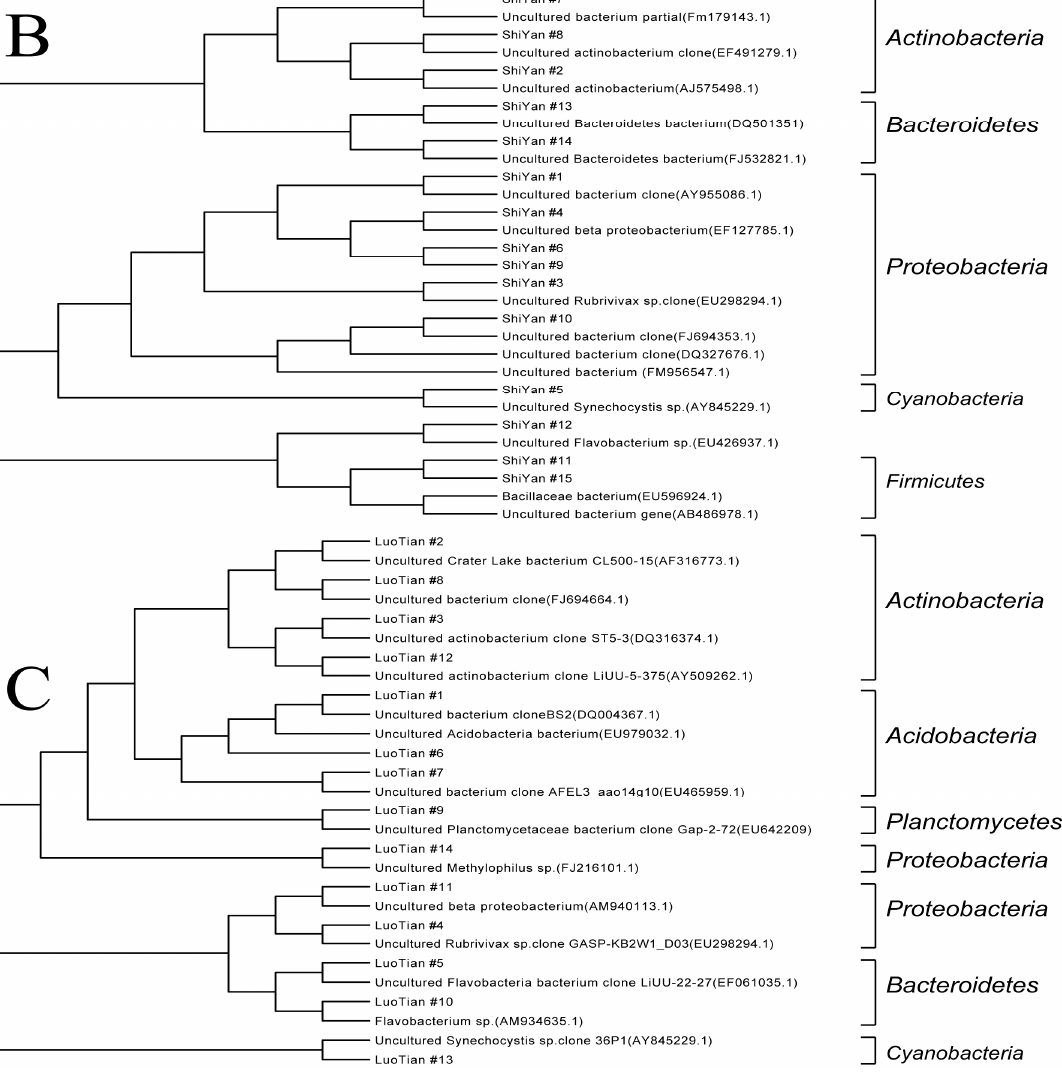
Figure 8. Phylogentic tree based on the excised DGGE band of three reservoirs. ( A ) Xi-keng Reservoir; ( B ) Shi-yan Reservoir; ( C ) Luo-tian Reservoir. Table 2. The proportion of bacterioplankton community structure in the three reservoirs. Reservoirs Bacteria